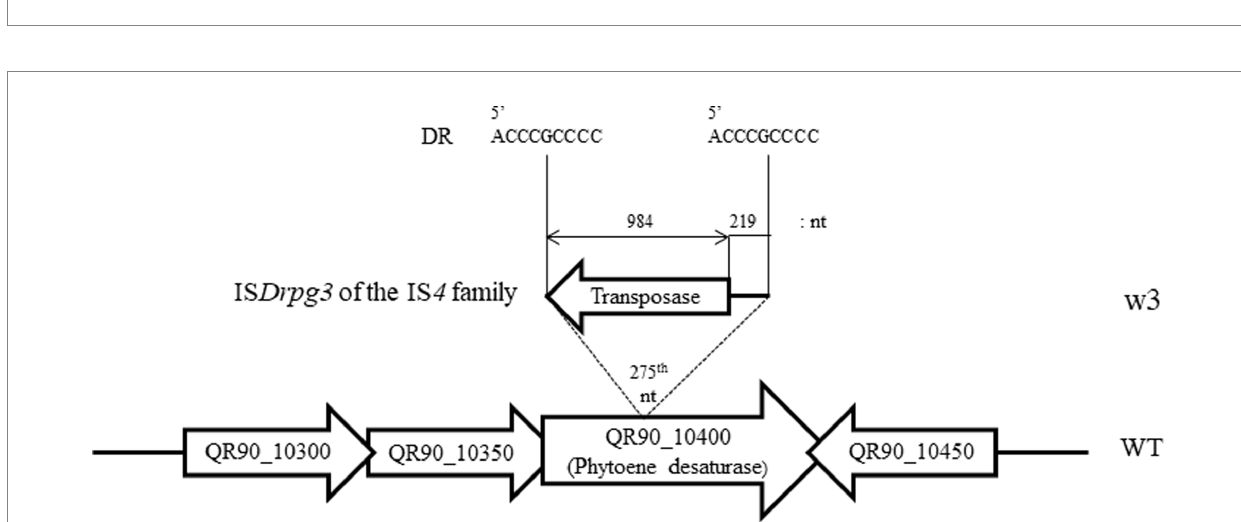
FIGURE 4 Detection of IS integration loci and composition of IS element in QR90_10400 phytoene desaturase in w3 mutant obtained after 300 mM H 2 O 2 treatment. The IS Drpg3 of the IS 4 family member was integrated at the 275th nt locus of the QR90_10400 gene with reverse transcriptional